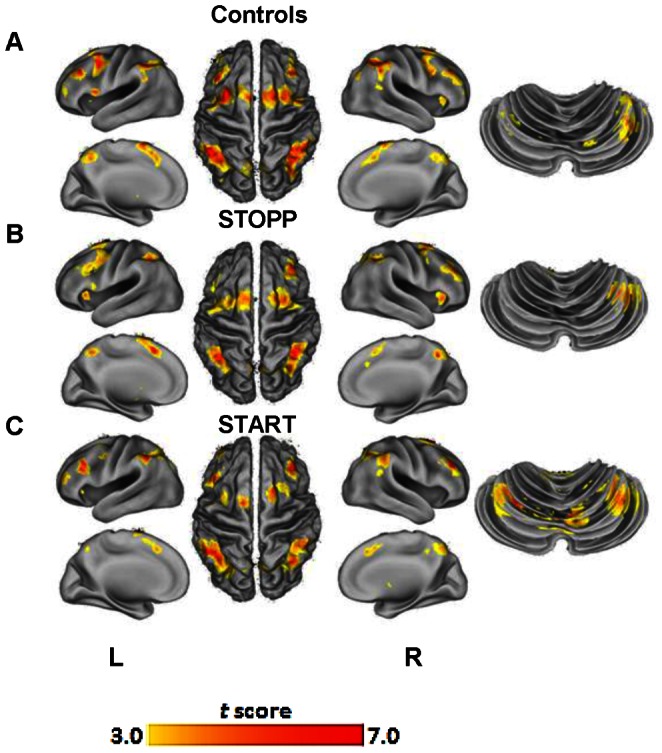
Pre-exercise compensatory activation during cognitive task.(A) Controls significantly activated regions normally associated with working memory in the frontal and parietal lobes and basal ganglia. (B) STOPP subjects activated normal working memory regions in addition to significant areas in bilateral anterior insula and right caudate body. (C) START subjects activated cortical regions associated with working memory and extensive activation of bilateral posterior-lateral cerebellum and right vermis. Whole-brain maps are displayed at P<0.001 and were cluster corrected for multiple comparisons at P<0.05 using AlphaSim.